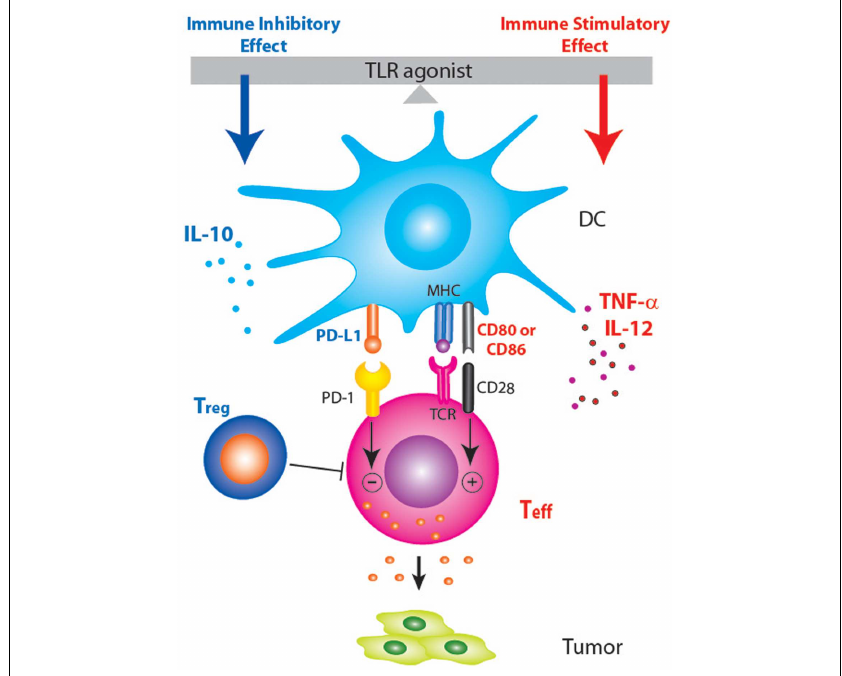
FIGURE 1 | Schematic diagram showing that PD-1/PD-L1 blockade may enhanceTLR-based immunotherapy by tipping the balance between the immune stimulatory and inhibitory effects of TLR agonists .Treatment withTLR agonists in tumor-bearing host not only induces pro-inflammatory anti-tumor responses but also induce anti-inflammatory factors (IL-10,Treg, and PD-L1) that dampen anti-tumor immune